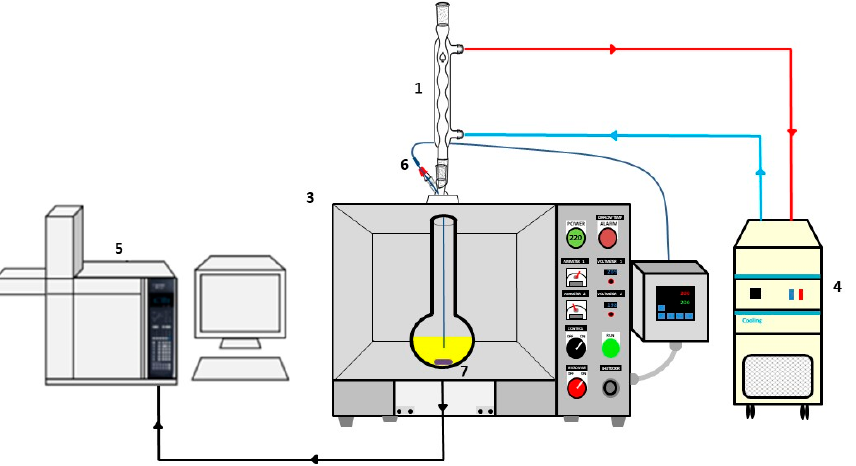
Figure 8. Schematic diagram of oligomerization system for 1-decene: (1) glass reactor; (2) condenser; (3) microwave system; (4) cool water circulator; (5) gas chromatograph; (6) thermocouple probe; (7) magnetic